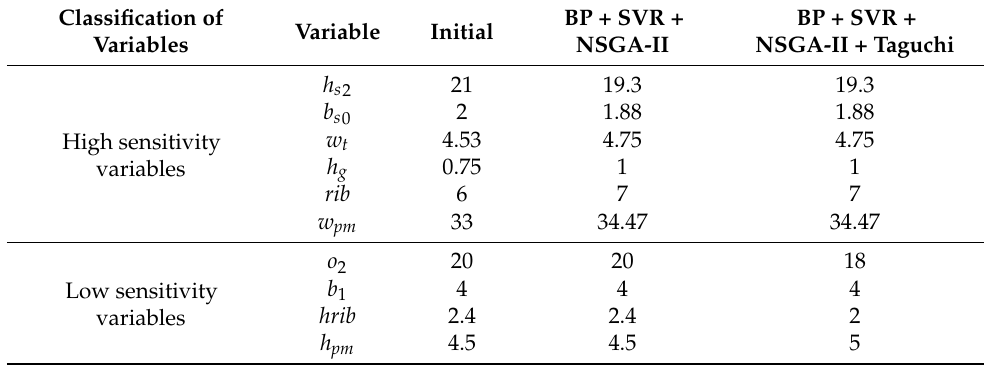
Table 9. Design variables for the initial and optimized motors.